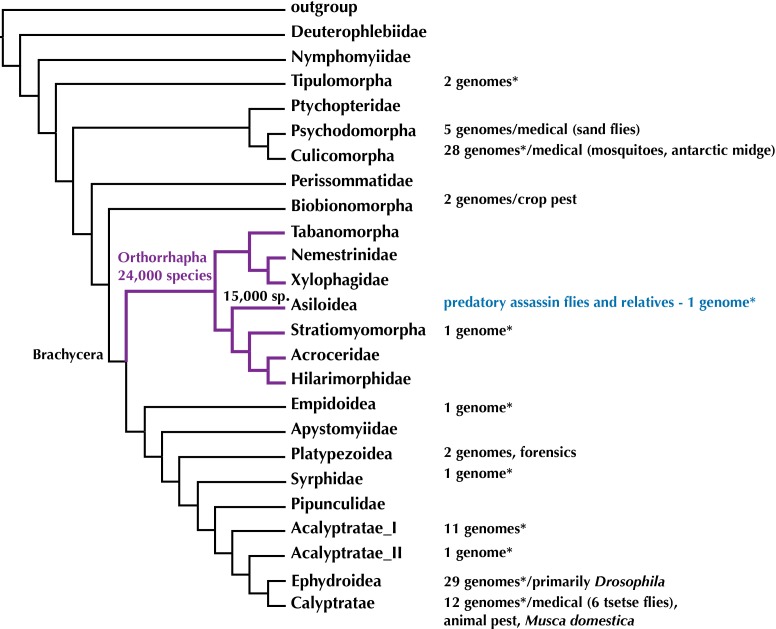
Phylogeny of Diptera (summary tree of hypothesis with higher taxa by Wiegmann et al., 2011) with number of completed genomes and position of Asiloidea.* = includes low-coverage genomes published recently in Vicoso & Bachtrog (2015). Figshare doi: 10.6084/m9.figshare.4056057.